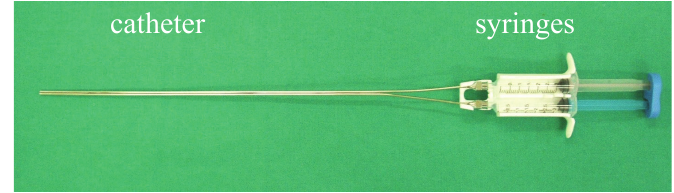
FIGURE 2 - The double-lumen cannula in which was attached two syringes with the two components of fibrin